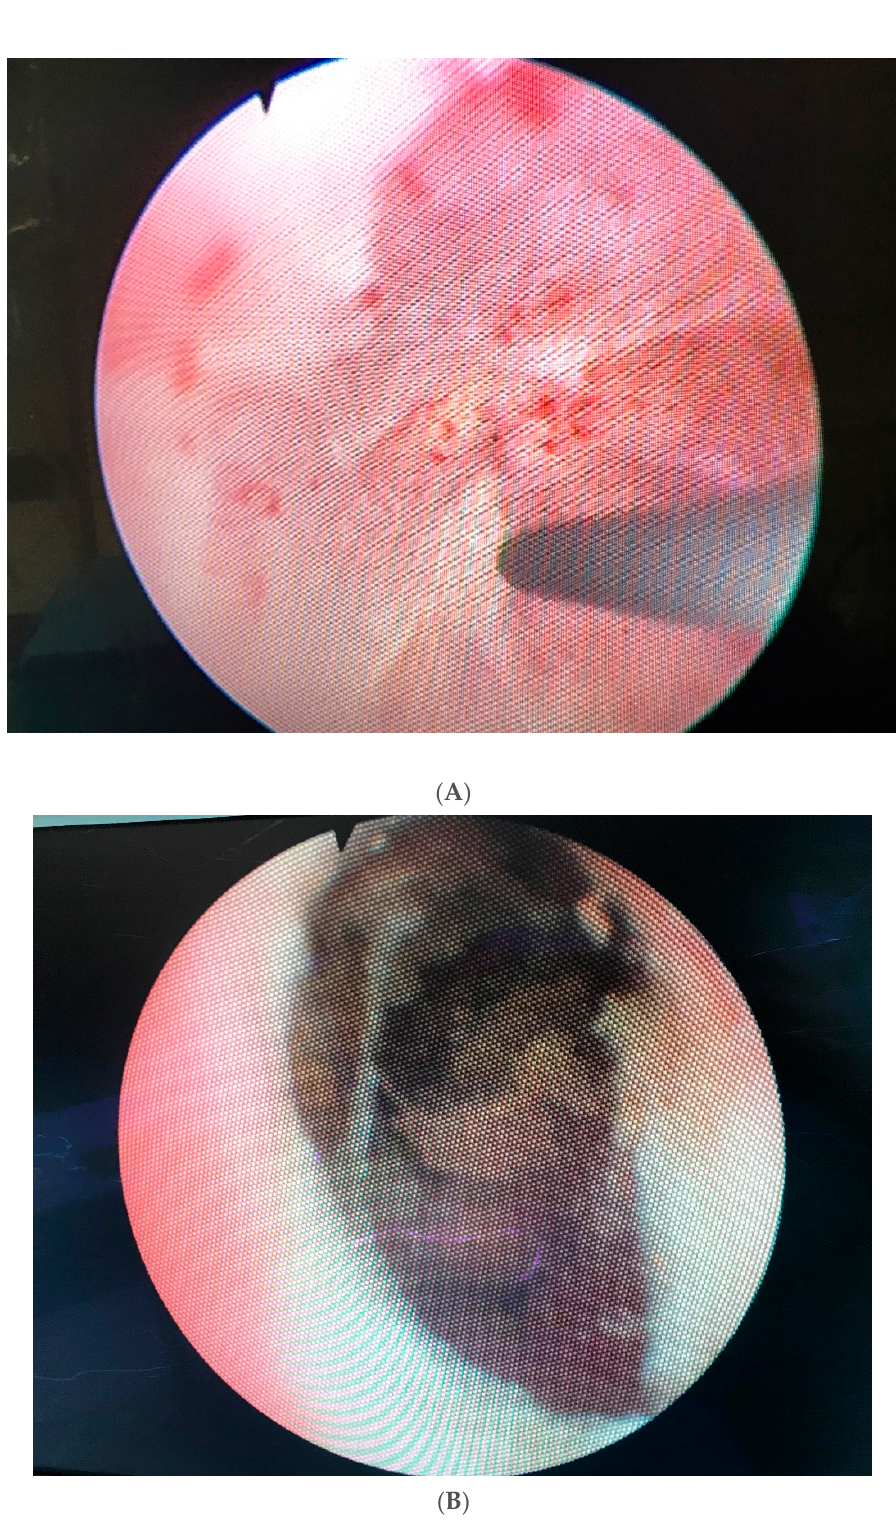
Figure 1. ( A ). Completely obliterated bulbomembranous stenosis ( B ). Fibrotic and necrotic posterior urethral tissue with calcifications caused by radiation.